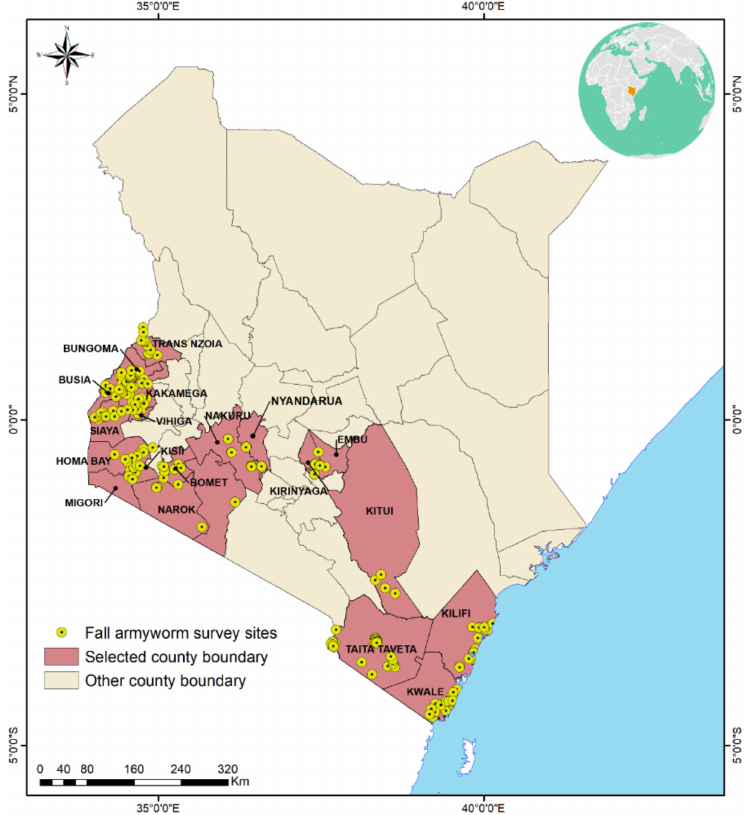
Figure 1. Map of Kenya showing all fall armyworm sites